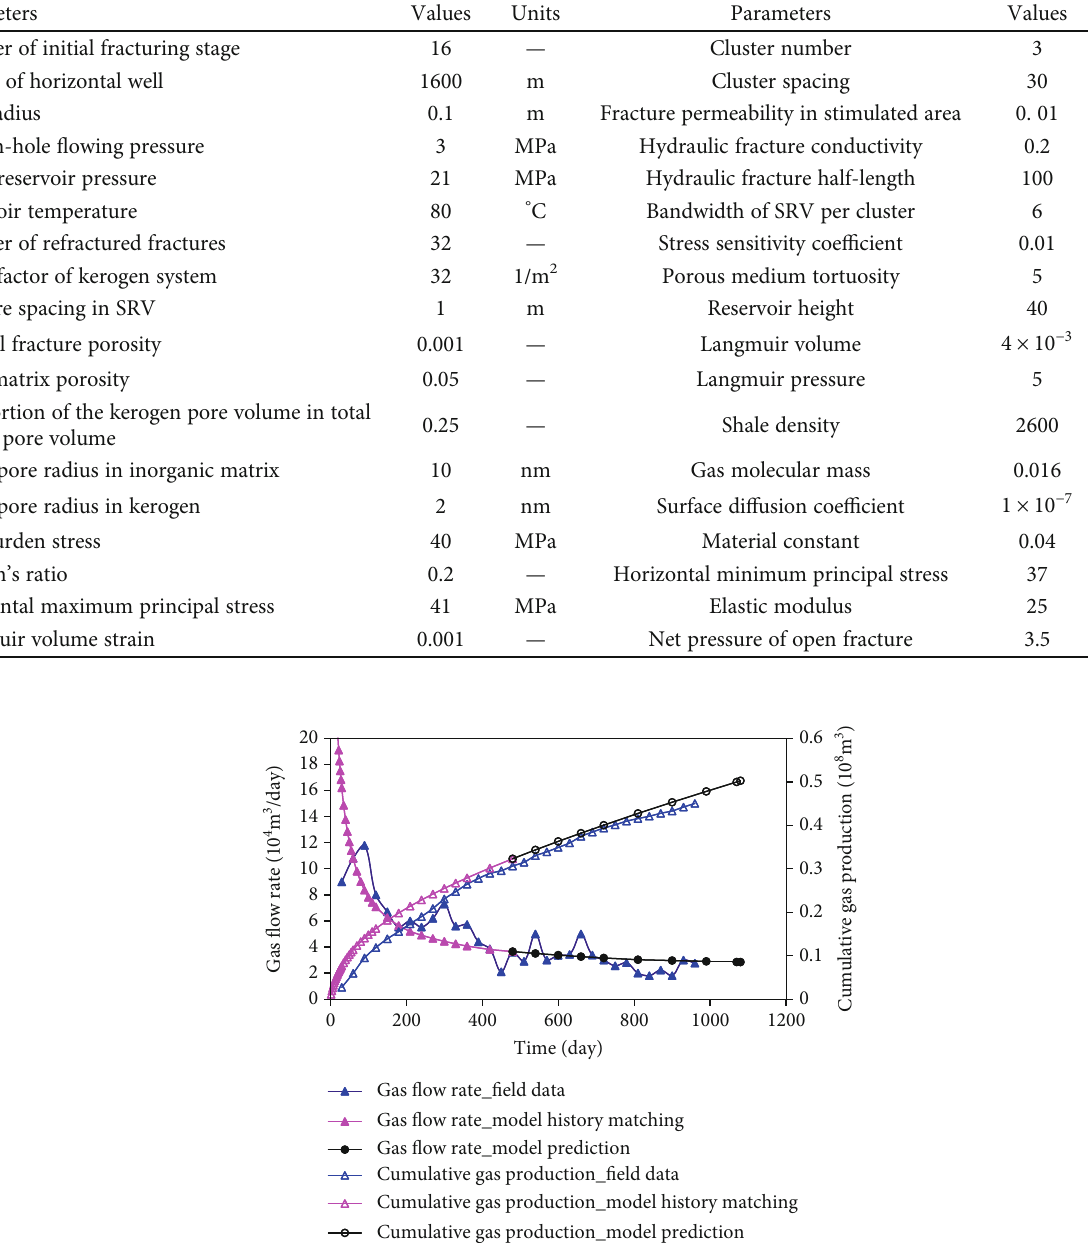
Table 1: Reservoir and fracture parameters used in this simulation.